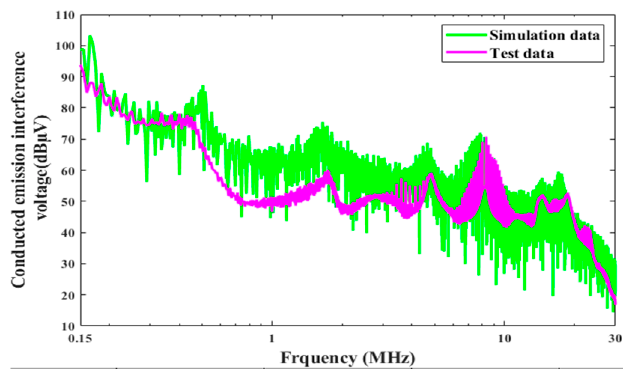
Figure 7. EMI emission simulation model of motor drive